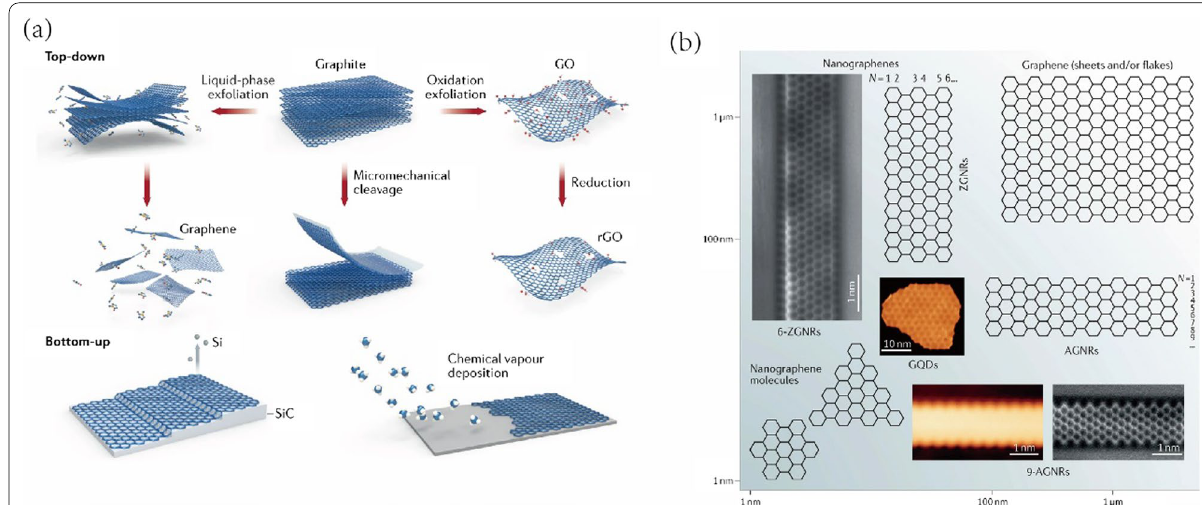
Fig. 2 a Two main routes to prepare GBNs: “Top-down” splitting approach and “Bottom-up” synthesis approach. b Classifications of graphenes based on lateral size. The GQDs represent graphene quantum dots. Referred from [34] with